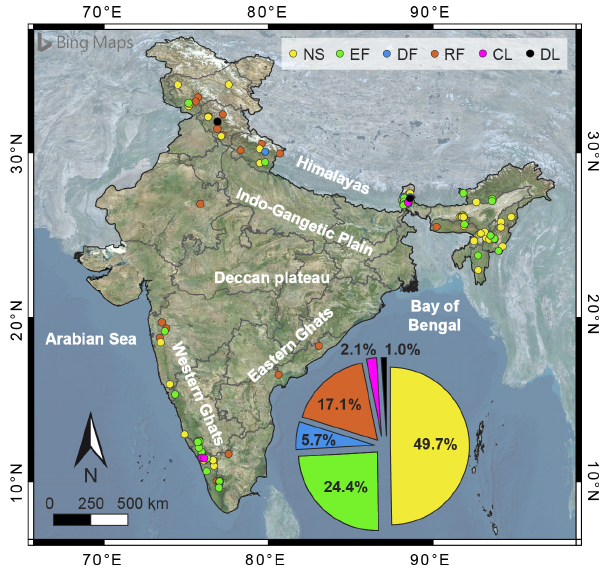
Figure 4. Map of the location of the six types of landslide and the relative percentages. Key: CL, complex landslides; DF, debris flow; EF, earth or mudflow/mudslide; RF, rockfall/rockslide; DL, un- specified deep-seated landslide; NS, non-specified landslide. Back- ground image from Bing ©